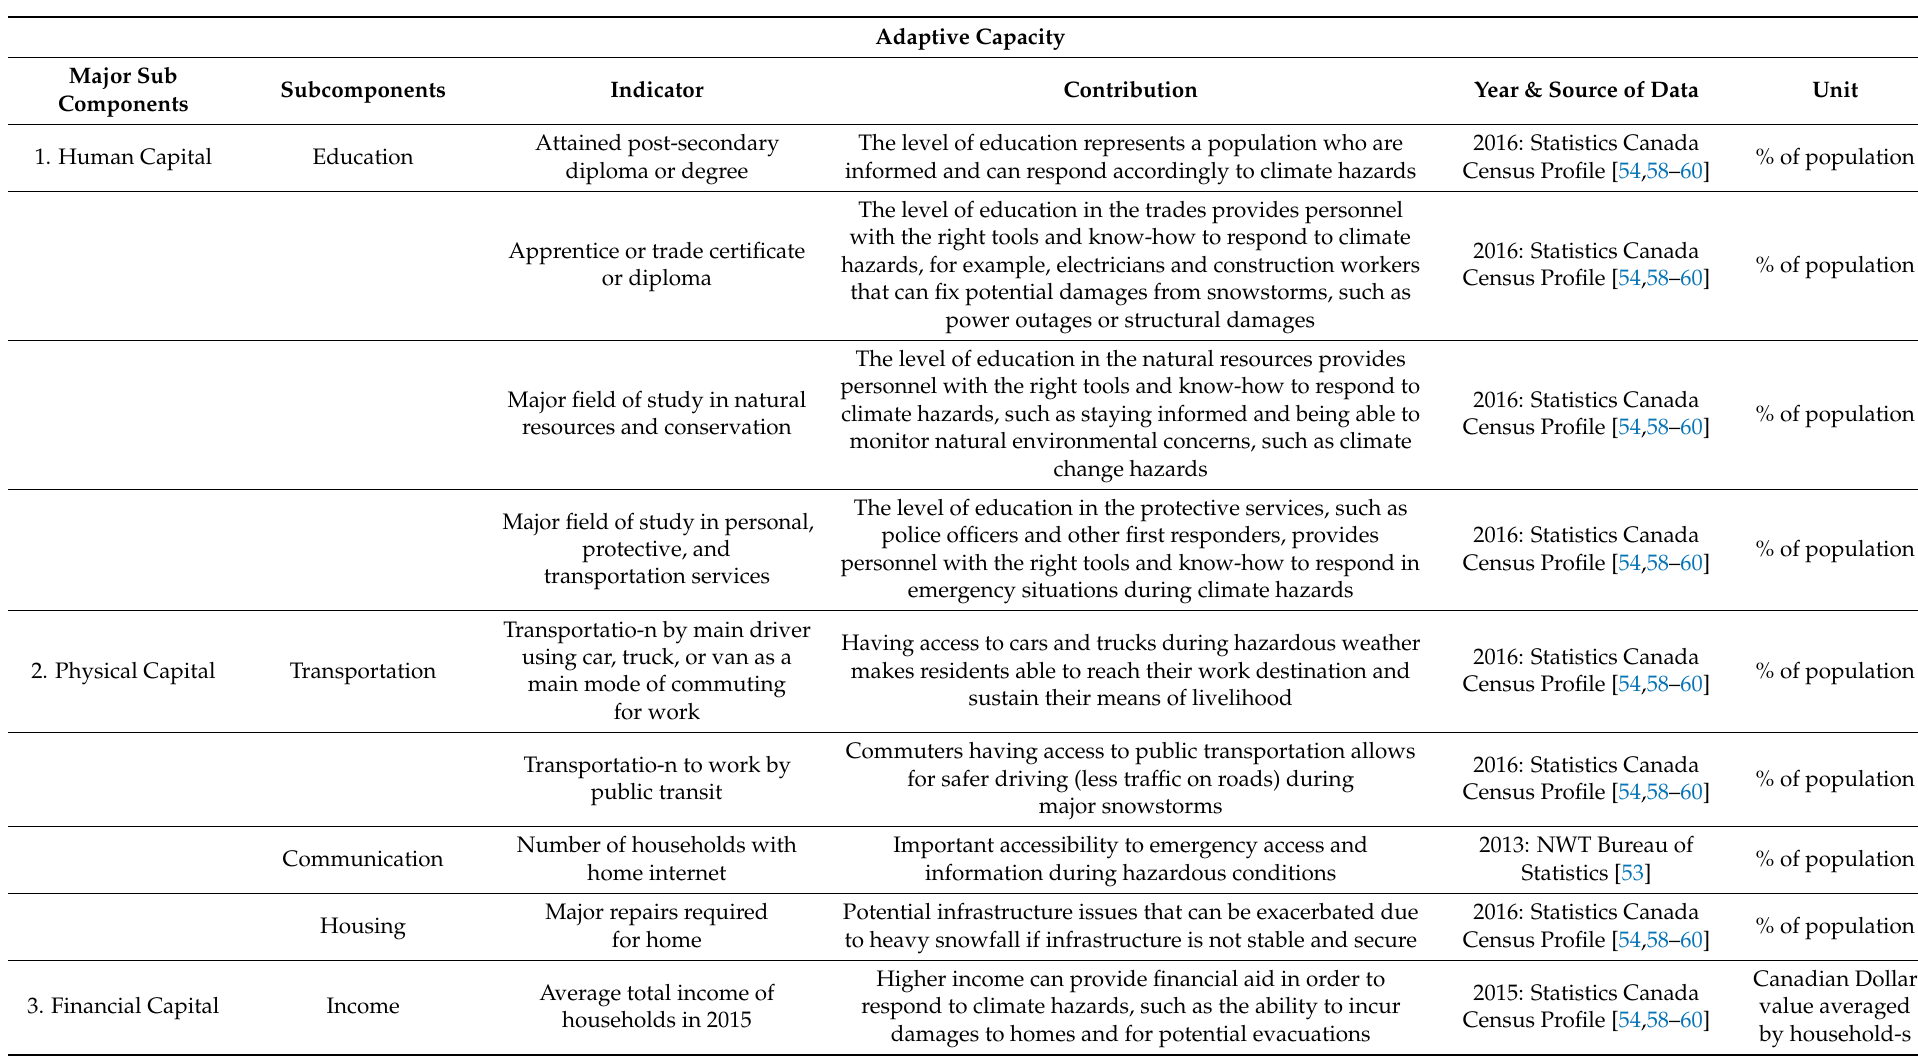
Table A2. Framework outlining the subcomponents and indicators under each major component, along with a description of each indicator, the year and data source provided, and units of each